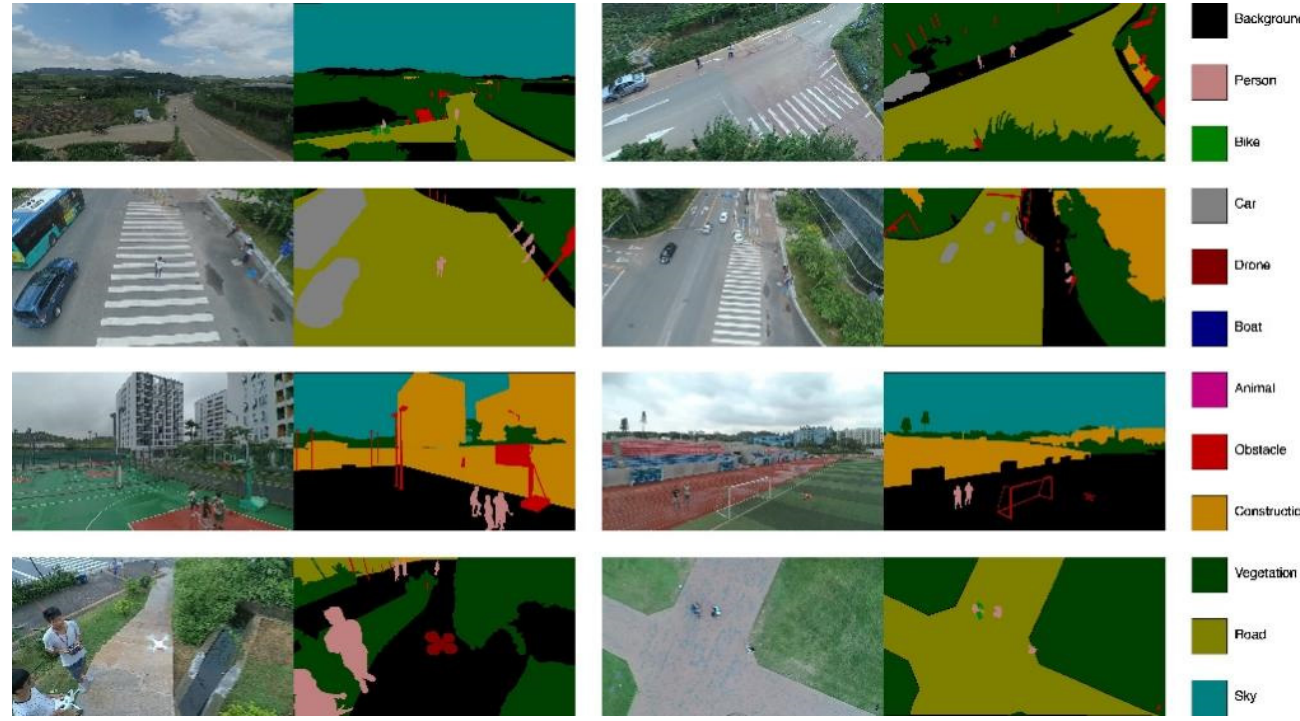
Figure 8. AeroScapes dataset.